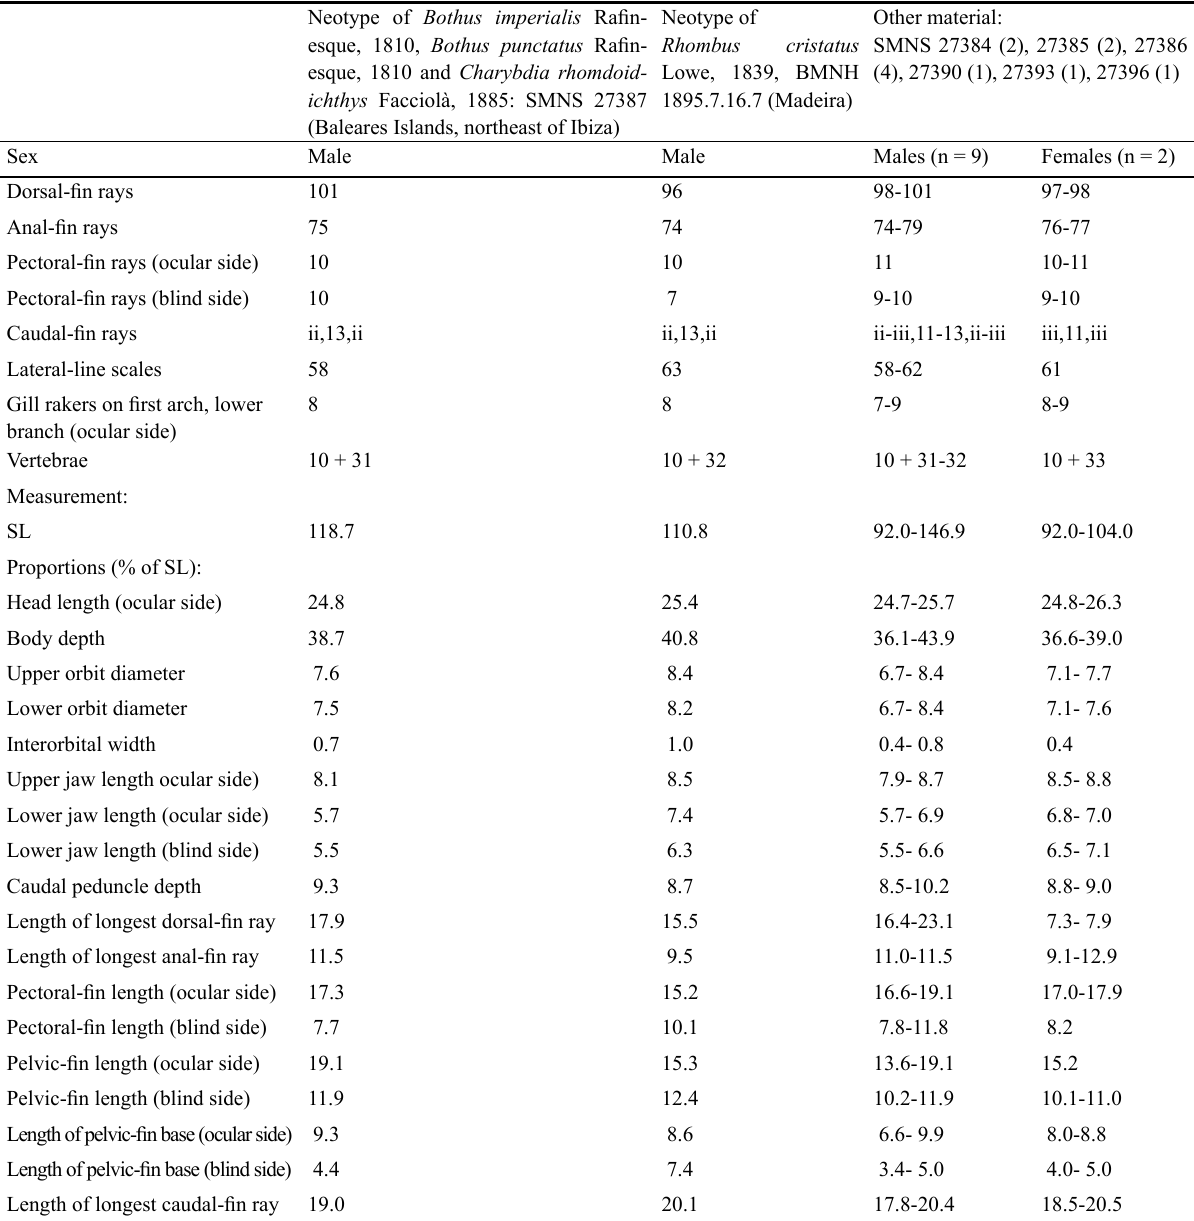
Table 4. – Counts and measurements [mm] of Arnoglossus imperialis (Rafinesque,